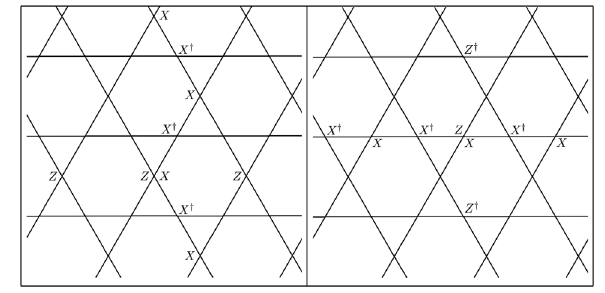
~ X † XX † … , ~ Z 1 ¼ XX 1 ¼